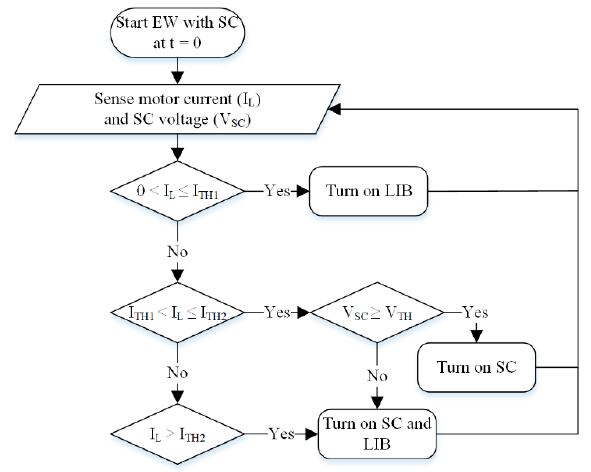
Figure 5. Algorithm for the SEMS.